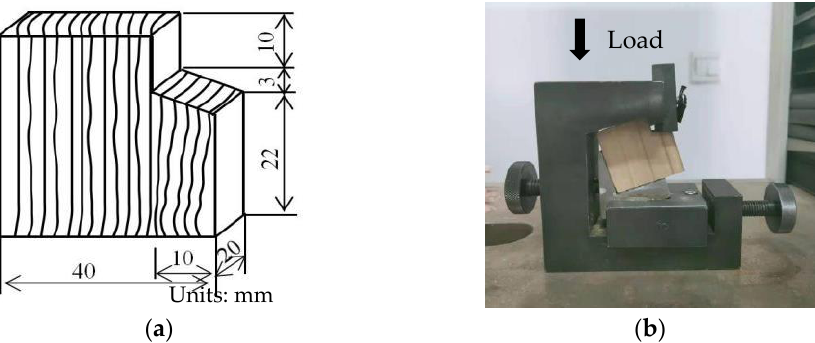
Figure 1. Schematic diagram of the shear specimen. ( a ) Dimensions and shapes of shear speci-mens. ( b ) Direction and position of load.